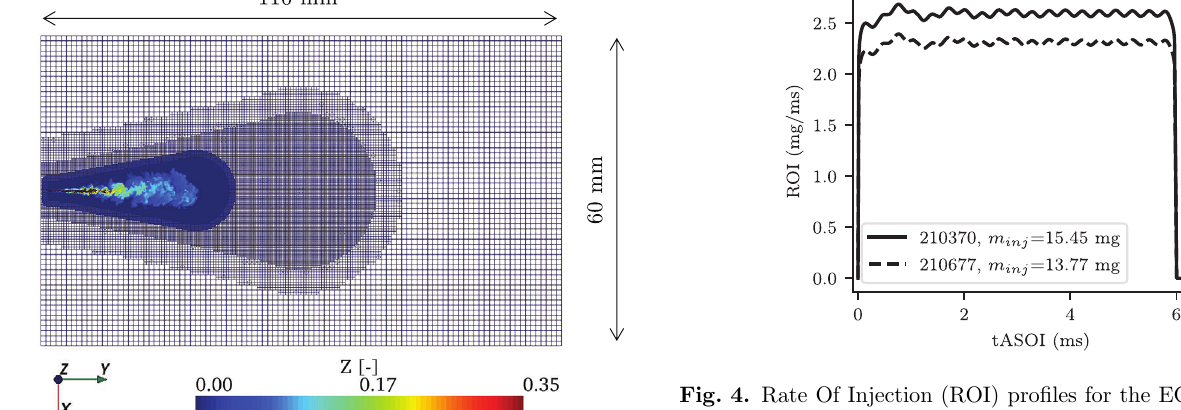
Fig. 4. Rate Of Injection (ROI) pro fi les for the ECN Spray A injectors. ROI shapes are obtained from the virtual injection rate generator [51] with the overall injected mass evaluated as the integral of the given ROI pro fi les. Note, that the ROI for the injector 201677 is scaled to ensure the experimentally given value for the injected mass of 13.77 mg [52].